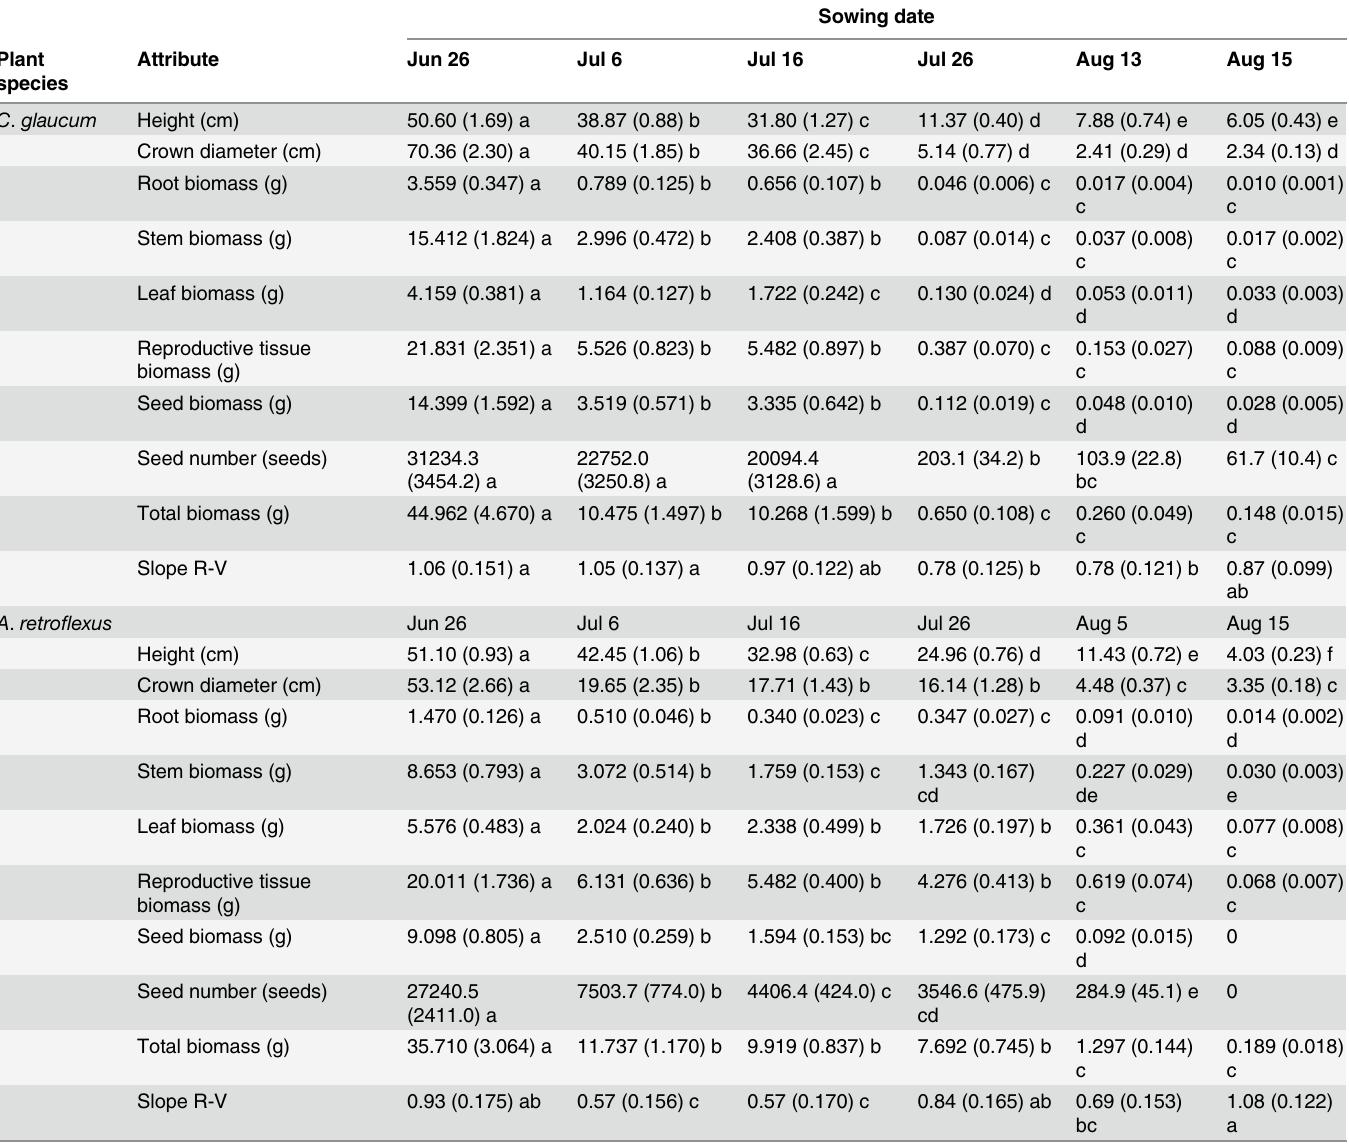
Table 2. Effect of sowing date on height, crown diameter, biomass accumulation, seed biomass, and seed production (seed number), total bio- mass, and the slope of the transformed reproductive biomass — vegetative biomass relationship (R-V) of Chenopodium glaucum and Amaranthus retroflexus